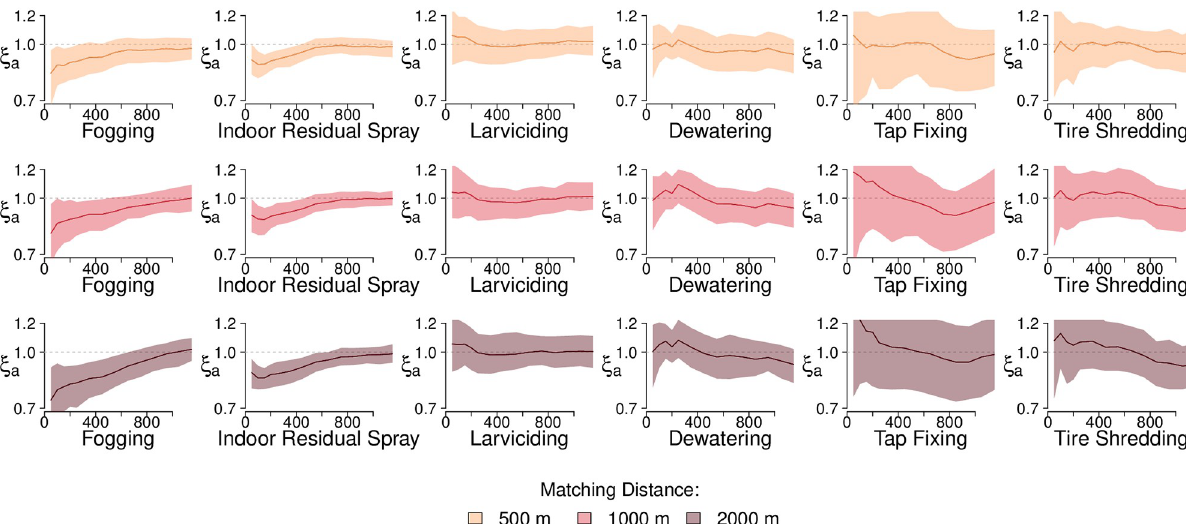
Fig 3. Variation in the effect of containment activity versus the distance (in meters) from index cases. Variation in the effect of containment activity, ξ ( d 1 , d 2 ), versus the distance (in meters) from index cases using data from Rawalpindi and Lahore across various values of matching distance a m . Values of ξ a are calculated using containment and non-containment cases which appear in an m = 1000 m radius of each other. The spatial window of the analysis ( d 2 minus d 1 ) is maintained at 500 m when d 2 is greater than 500 m, and observations are made by sliding the window at intervals of 100 m. For d 2 less than 500 m, d 1 is equal to zero and observations are made by increasing d 2 at intervals of 100 m. Spatial dependence estimates are plotted at midpoint of the spatial window. Values below 1 show a lower probability of new cases appearing around a case in proximity of a containment activity, compared to a non-containment case. The time window t 2 − t 1 is set to 30 days. 95% CI from bootstrapping 100 replications are shown as shaded areas around estimates.